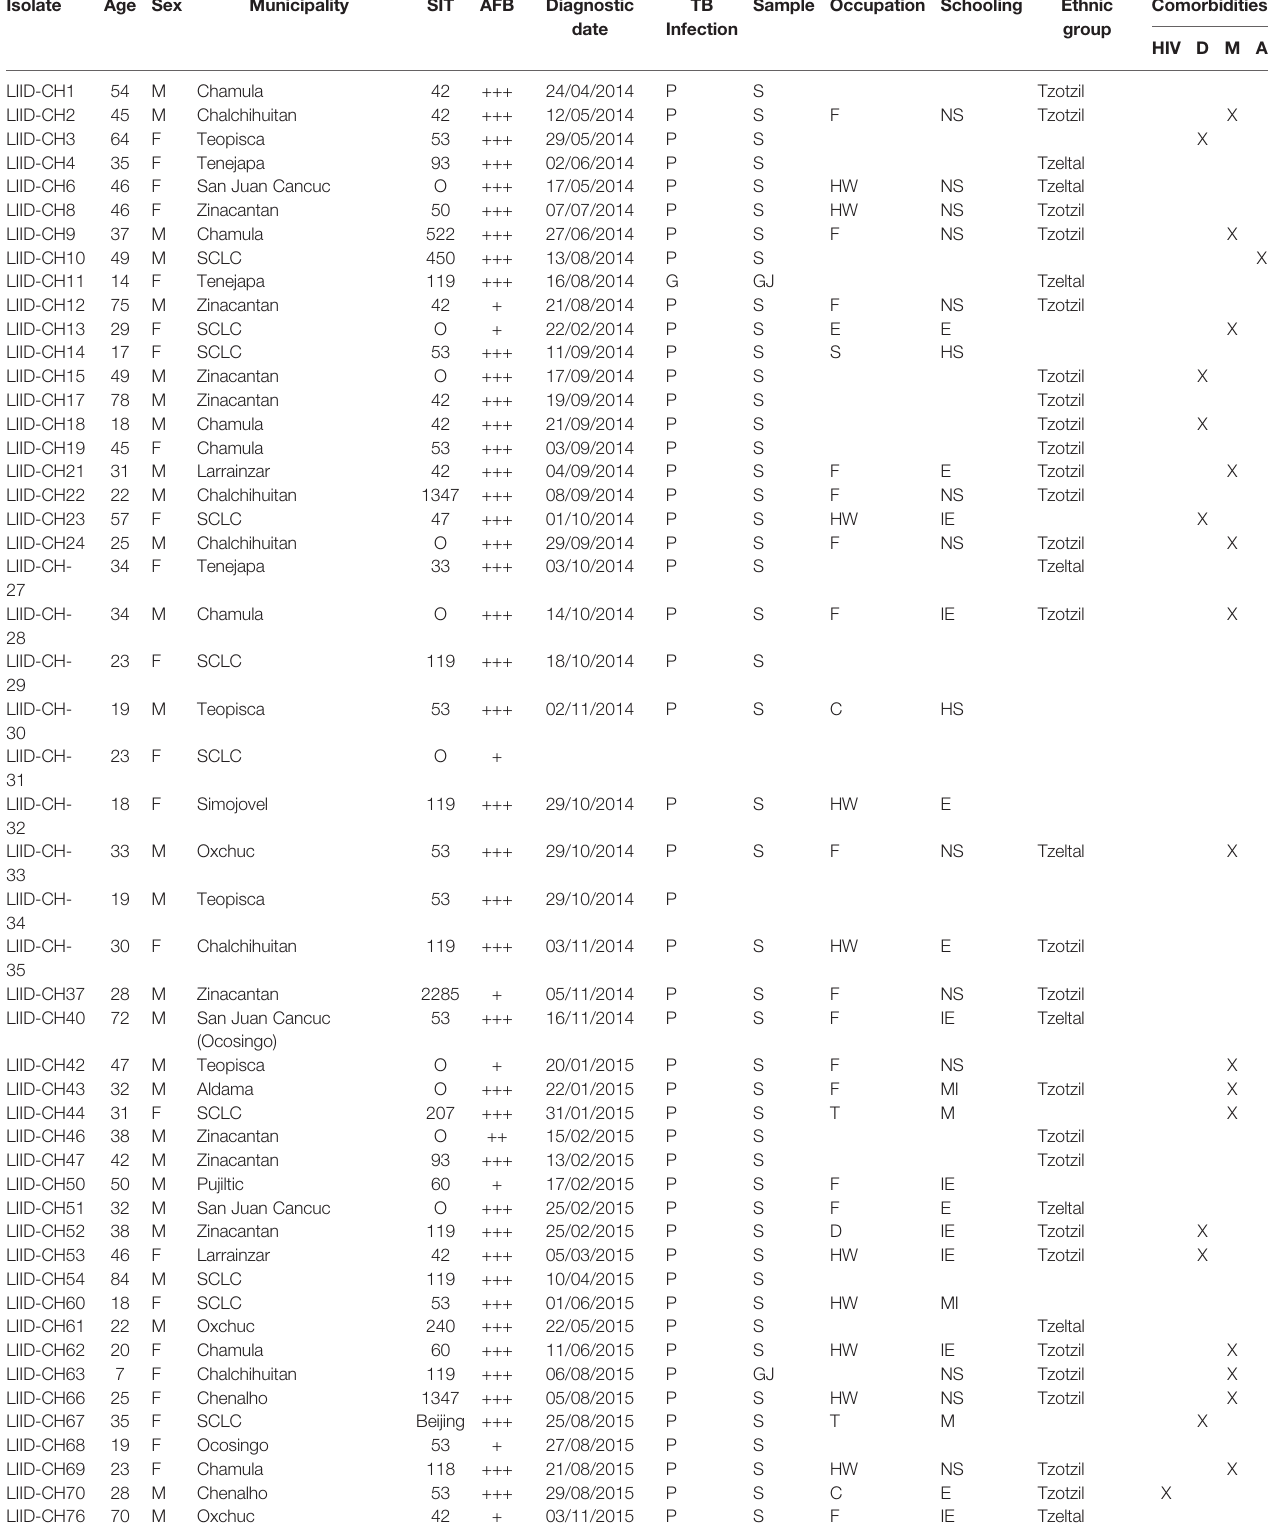
TABLE 1 | Demographic and clinical data of the study participants.